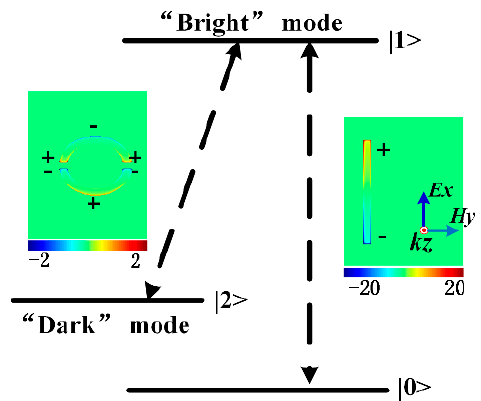
Figure 3. Schematic of interference with the classical 3-level resonant system. Inset: z-component of electric field ( E z ) distributions of the ‘dark’ ( left ) and ‘bright’ ( right ) modes.